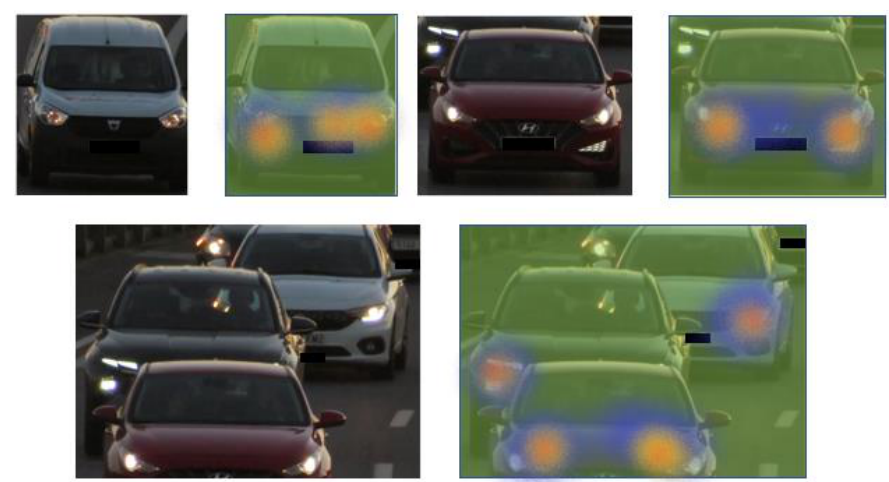
Figure 7. Example representation of attention maps [53].